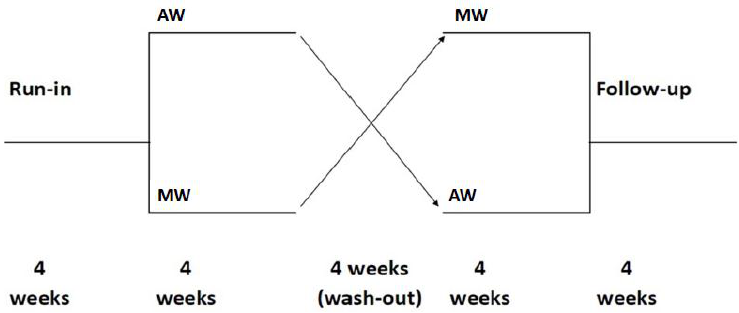
Figure 2. Flowchart of the trial. AW: ancient wheat foodstuffs, MW: modern wheat foodstuffs.